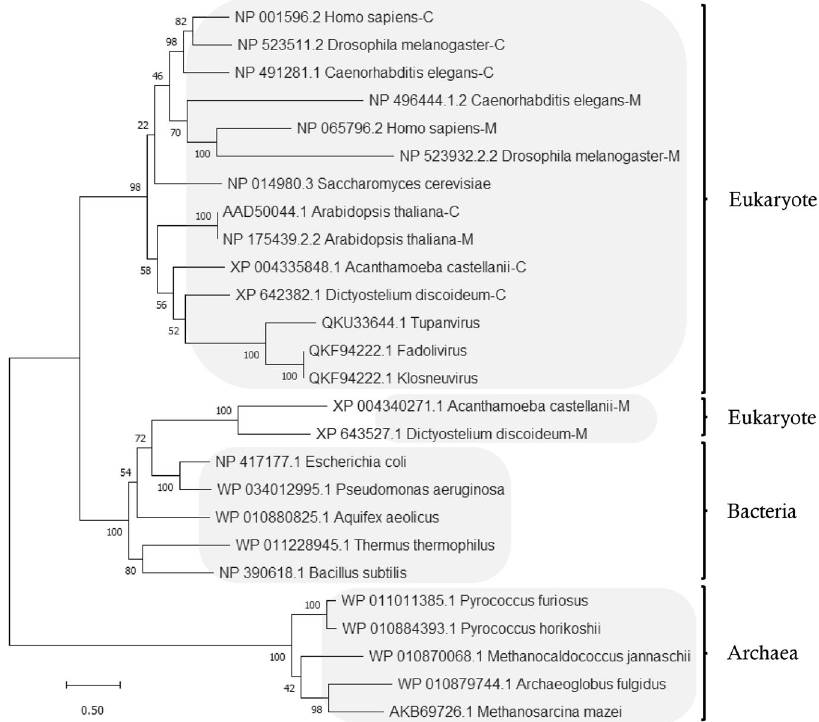
Fig. 5 Phylogenetic analysis of AlaRSs. The evolutionary history was inferred by using the Maximum Likelihood method and Le_Gascuel_2008 model. Initial tree(s) for the heuristic search were obtained automatically by applying Neighbor-Join and BioNJ algorithms to a matrix of pairwise distances estimated using the JTT model. A discrete Gamma distribution was used to model evolutionary rate differences among sites. This analysis involved 26 amino acid sequences. Evolutionary analyses were conducted in